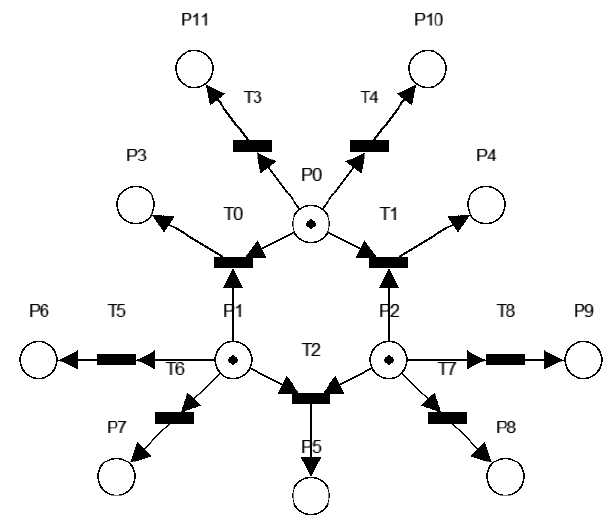
Figure 6. Petri Net model with concurrent parts.